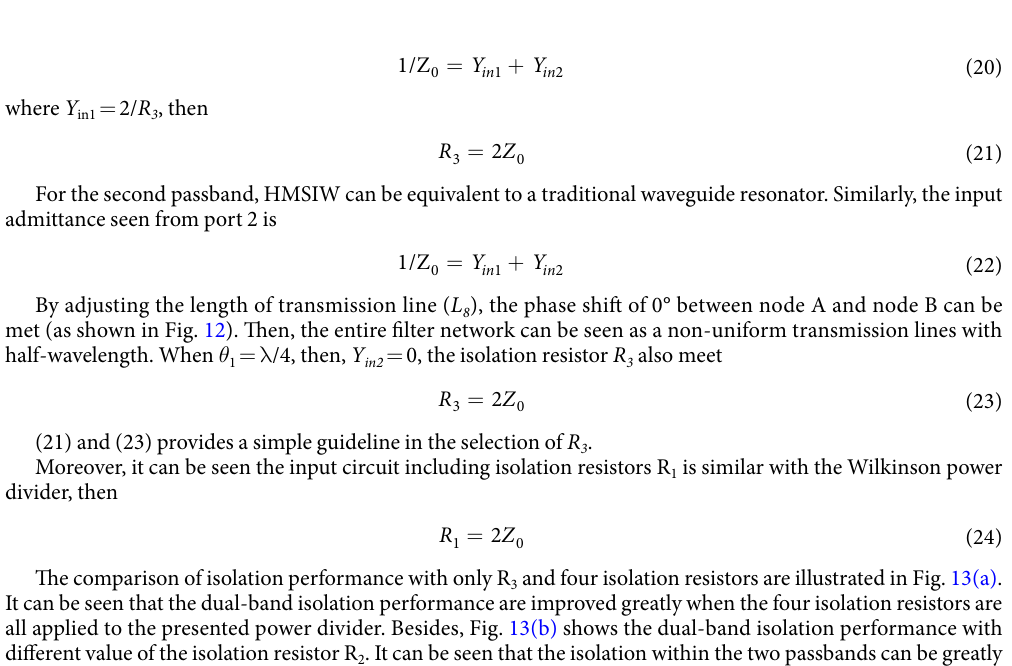
Figure 13. ( a ) Comparison of isolation performance with only R 3 and four isolation resistors. ( b ) Isolation performance with different R 2